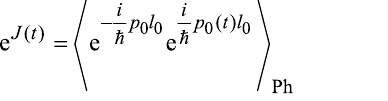
self-energies ∑ L/R (wide band limit) gives the forward rate onto the dot from the left